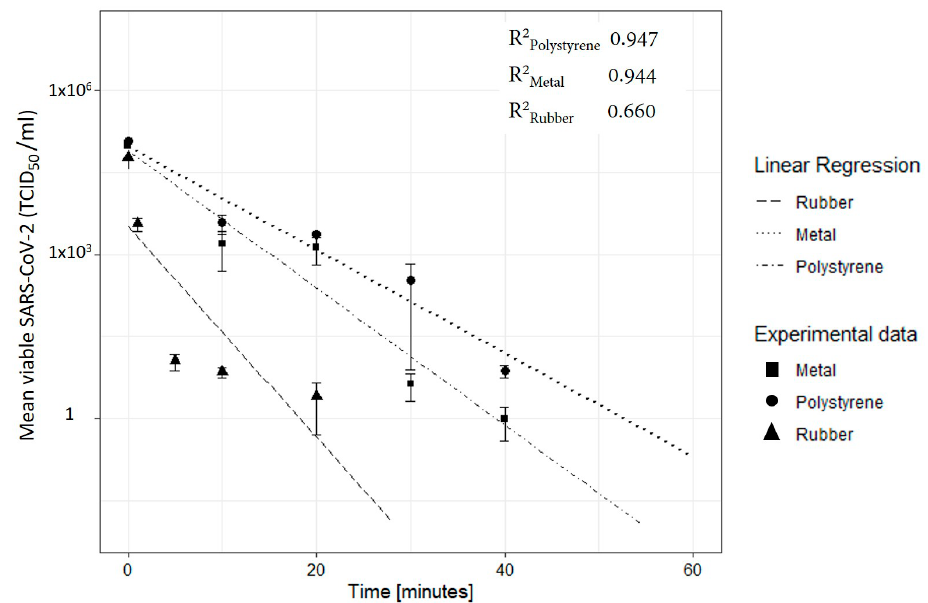
Figure 4. UVC Susceptibility measured on different surfaces. The mean ± SEM values from experi- ments ( n = 3) are indicated for polystyrene, metal and rubber; the lines represent the best-fit linear regressions of experimental data.